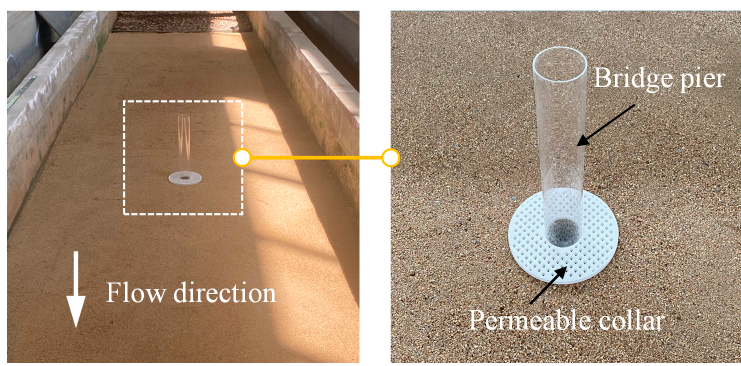
Figure 6. Model of the bridge pier and the permeable collar.